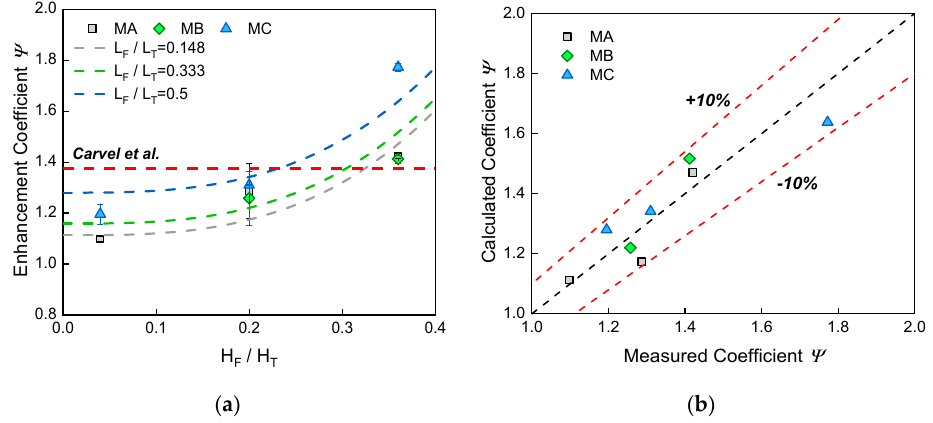
Figure 22. Comparison between experimental and estimated results of enhancement coefficient: ( a ) measured data and estimated curves; ( b ) calculated data and measured data.